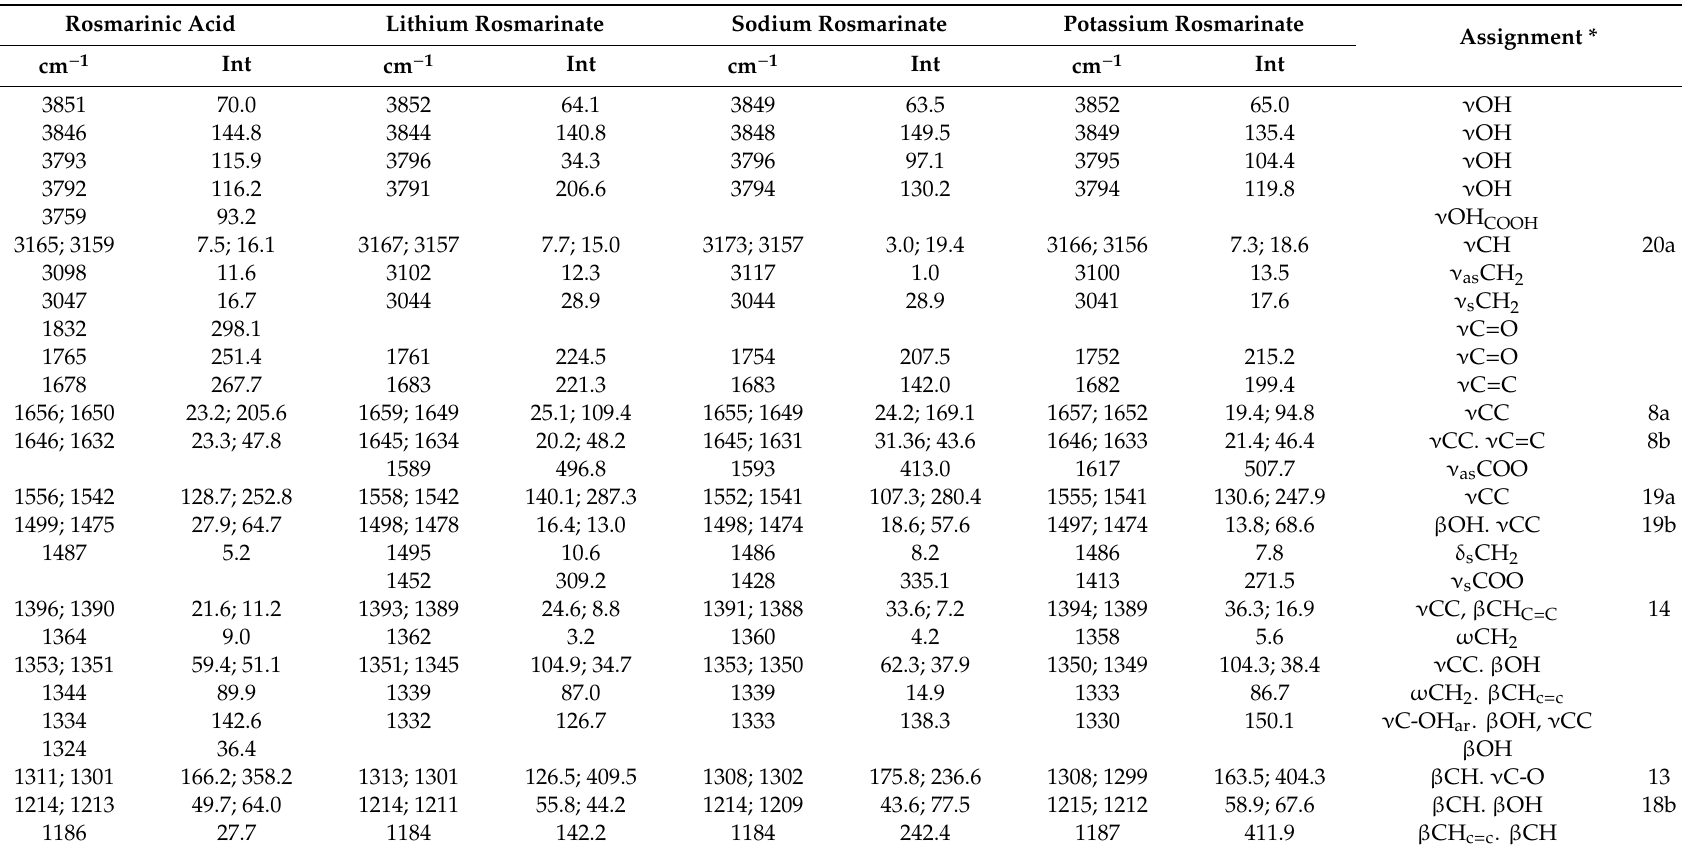
Table 4. Calculated wavenumbers (cm − 1 ) and intensities (Int) of bands in rosmarinic acid and its lithium, sodium and potassium salts spectra. Rosmarinic Acid Lithium Rosmarinate Sodium Rosmarinate Potassium